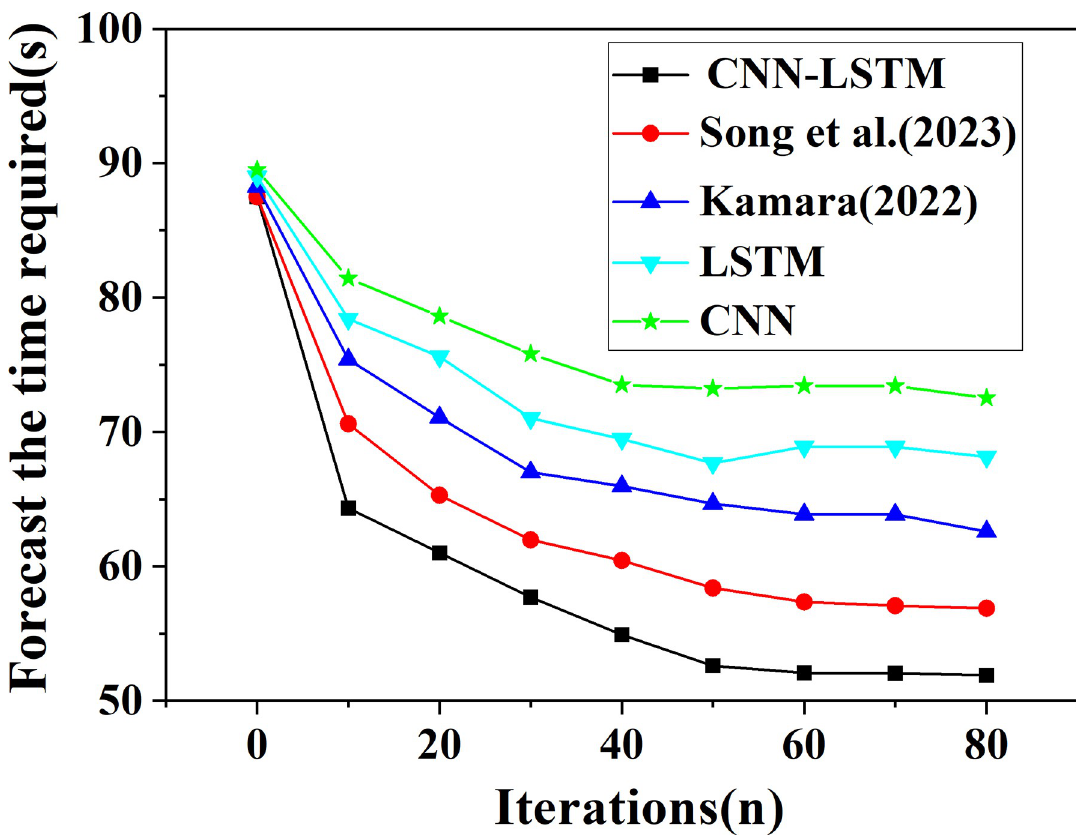
Fig 10. The influence curve of the time required for stock prediction with the increase of iteration times under different algorithms.